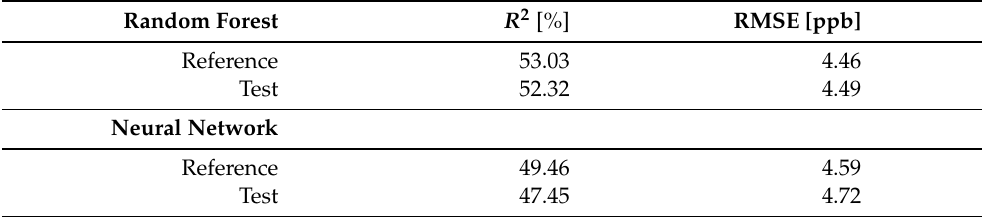
Table 4. Scores on the test set for the reduced training set excluding 10% of the non-influential training data